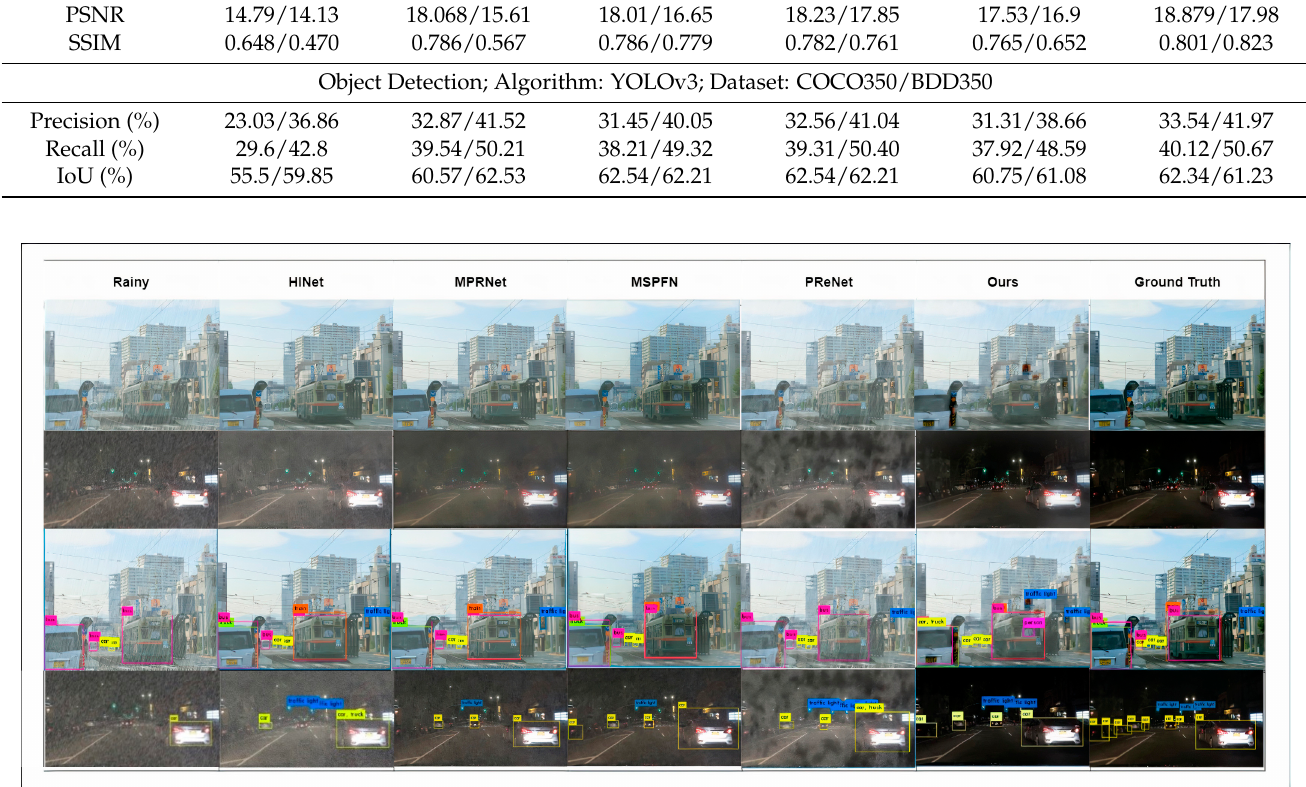
Figure 10. Examples of joint deraining and object detection. The first row denotes samples of the deraining results on COCO350 dataset; the second row denotes samples of the deraining results on BDD350 dataset. The third and fourth rows shows the results of object detection performed on the first and second rows sequentially. YOLOv3 has been used for object detection.